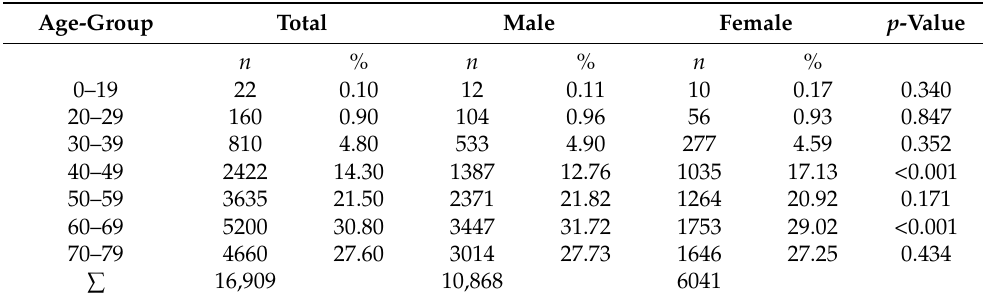
Table 3. The distribution of stomach cancer incidence by gender and age groups. Age-Group Total